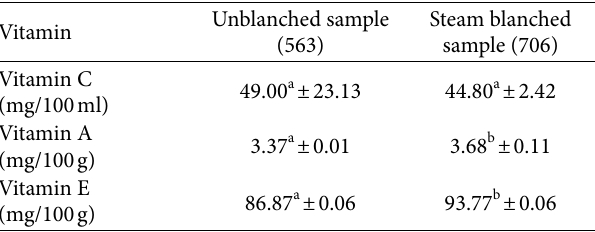
; mean ± SD. Values in a row followed by different letters in superscript 푛 = 3 are significantly